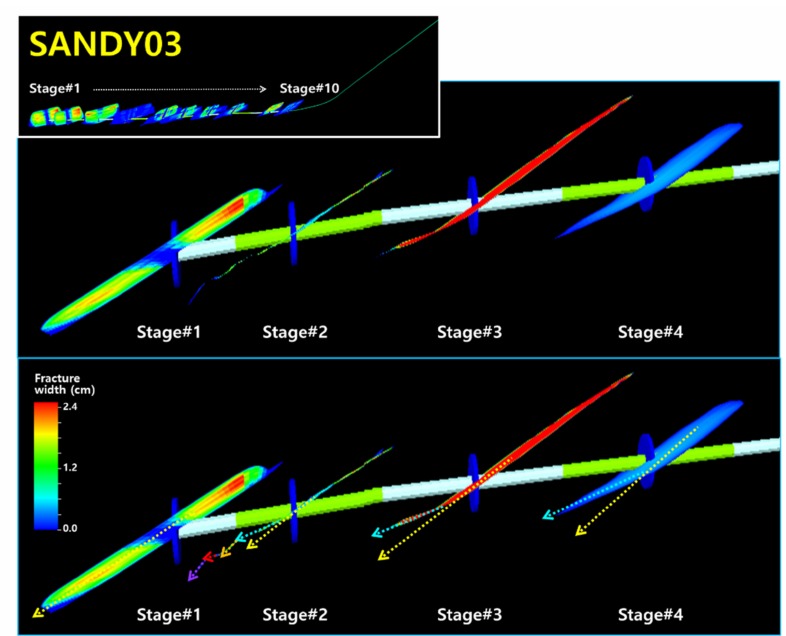
Figure 14. HF growth direction changes in